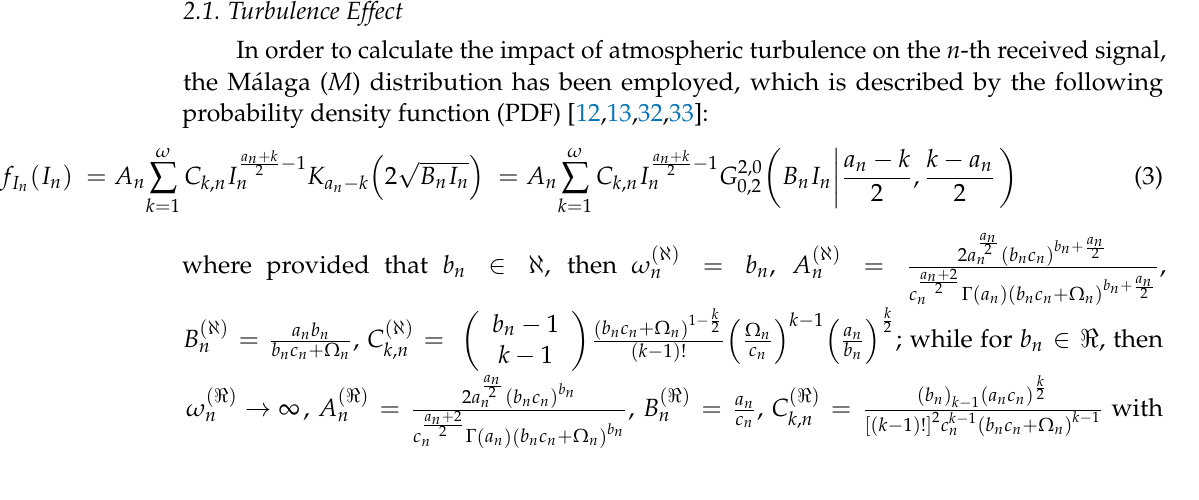
Figure 1. Schematic diagram of the system’s configuration with M DF relayed multi-hop and N OC receiver diversity for each individual